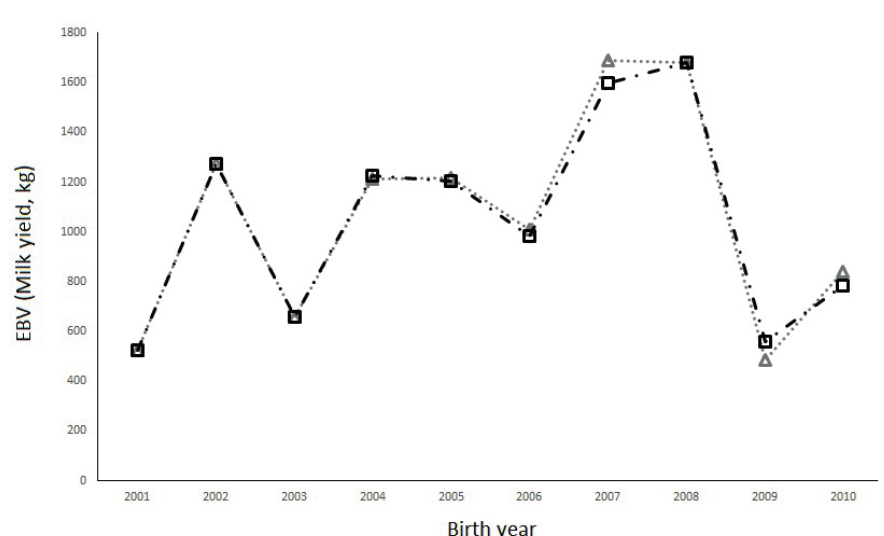
Fig. 4. Genetic trend of the phantom parent groups ‘sires-of-sires’ (gray triangle) and ‘dams-of-sires’ (black squares) of imported